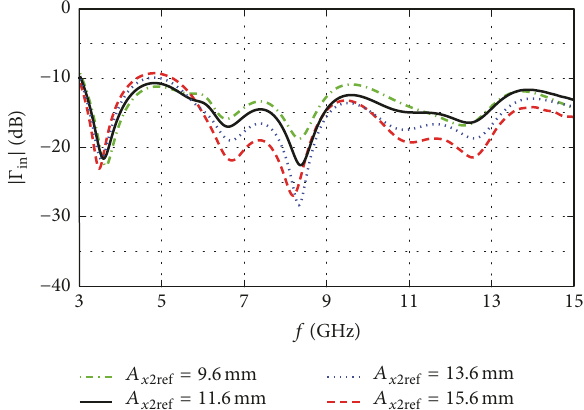
Figure 5: Magnitude of the input reflection coefficient versus frequency for the drop-shaped dipole antenna equipped with a metalreflectorcomputedfordifferentvaluesoftheparameter 𝐴 𝑥2 ref